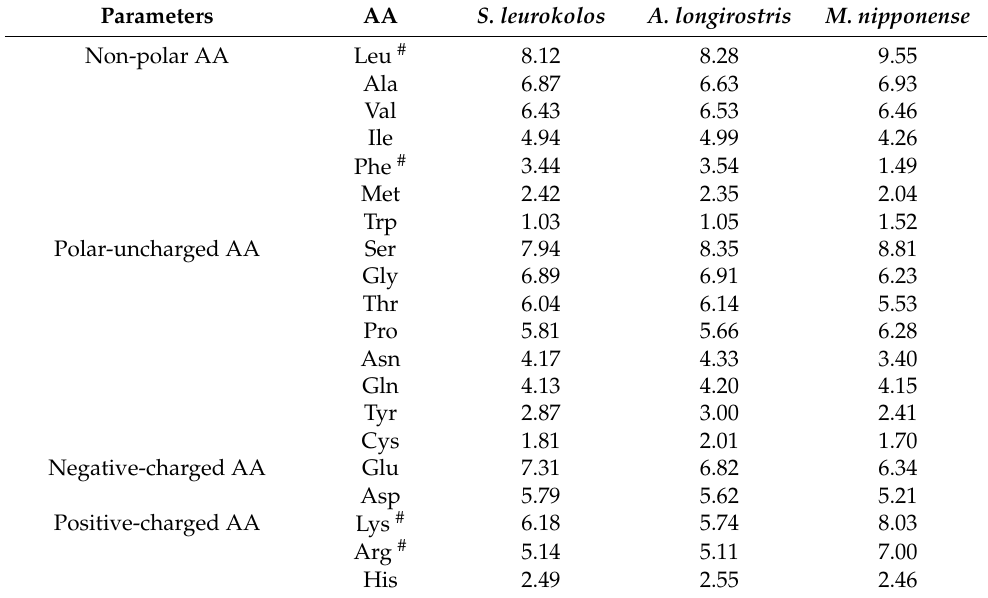
Table 3. The proportions (%) of amino acid of transcriptomes from S. leurokolos , A. longirostris , and M. nipponense . AA: amino acid. # The differences are larger than 1% between the two deep-sea shrimps and shallow-water M. nipponense